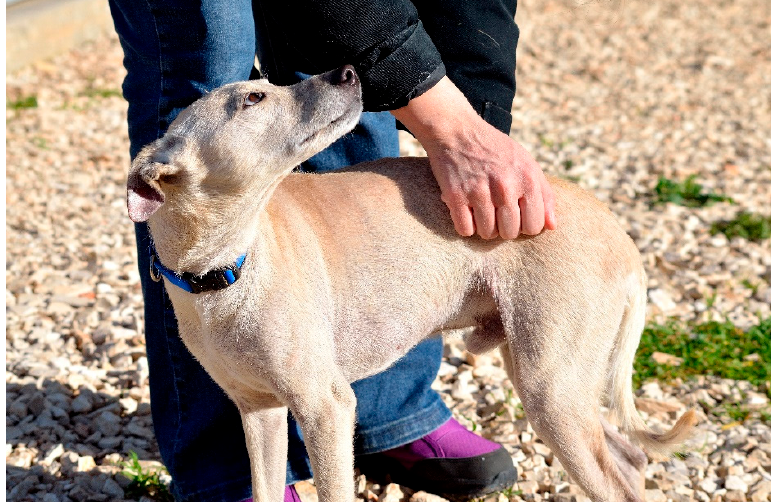
Figure 10. This dog is not relaxed during this tactile interaction. Although the physical contact is “gentle” (on the dog’s side and not on his head), the human is standing on the dog, making him feel uncomfortable.